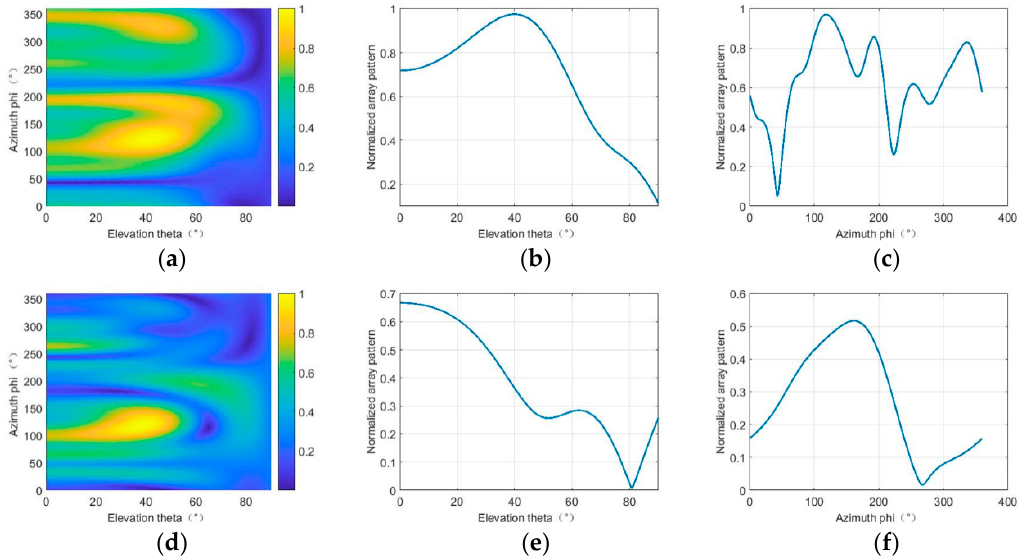
Figure 7. ( a ) is the array pattern of SMI beamformer, ( b , c ) respectively show the sections of ϕ = 113 ◦ and θ = 35 ◦ . ( d ) is the array pattern of ESB beamformer, ( e , f ) show the sections of ϕ = 270 ◦ , θ = 80 ◦ .